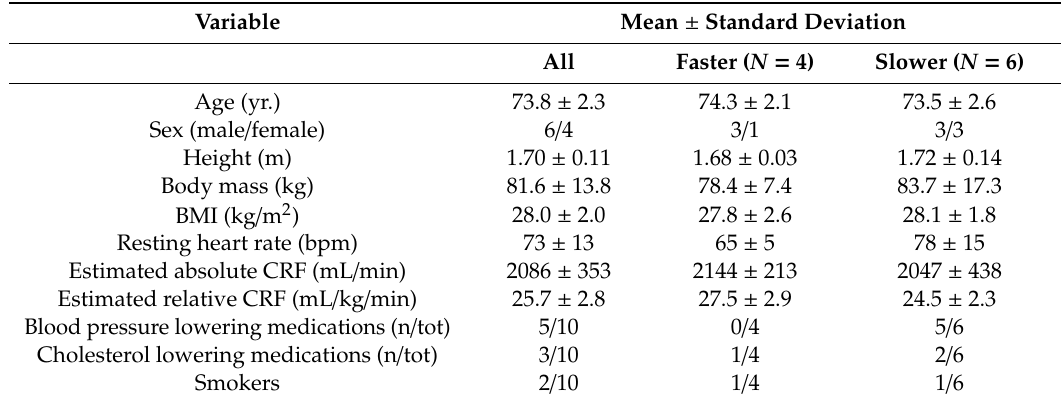
Table 1. Participants’ characteristics at